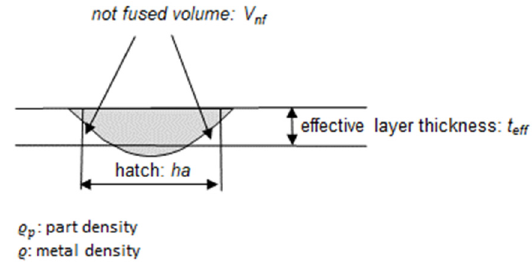
Figure 8. Scheme for the calculation of the part density from the calculated track geometry.